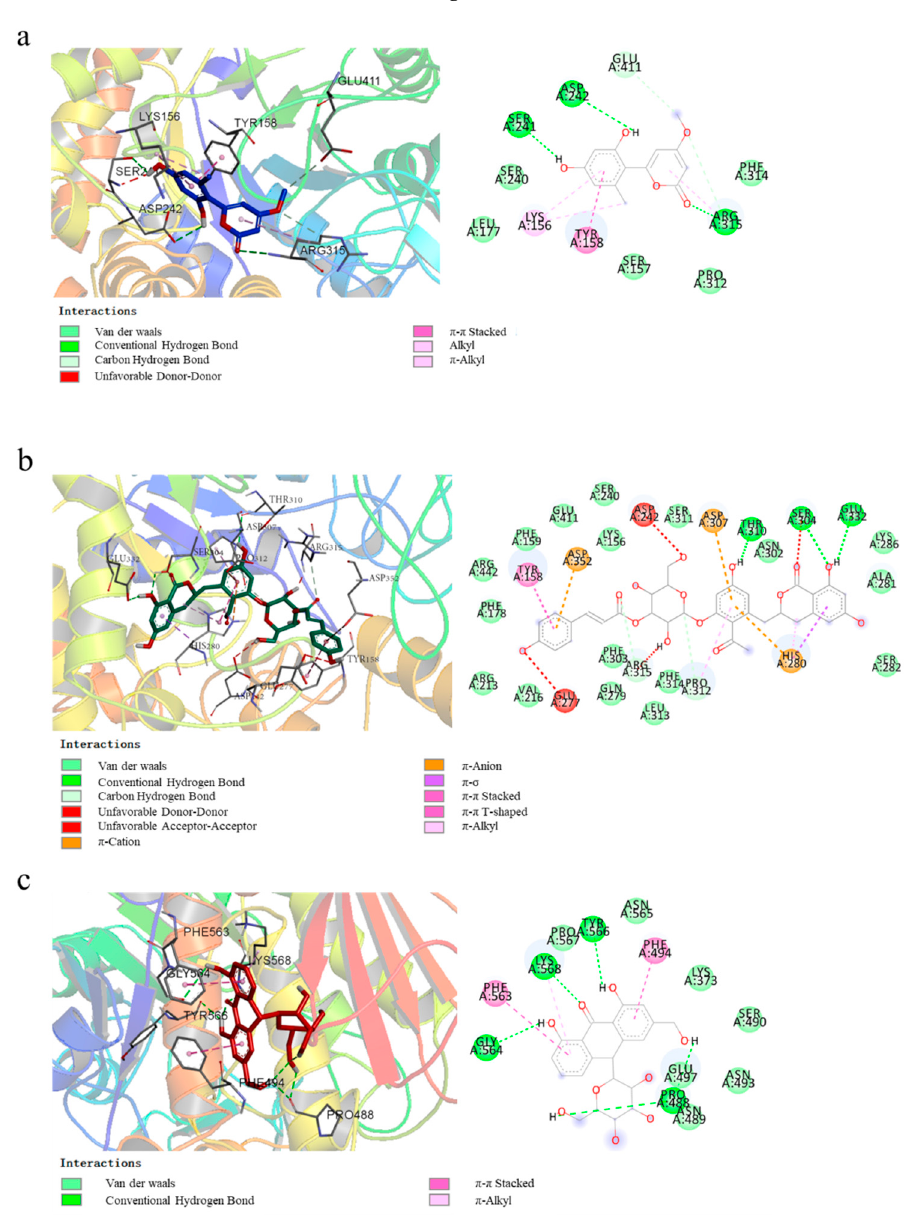
Figure 6. 2D and 3D molecular docking graphs of ( a ) compounds 1 , ( b ) compound 2 and ( c ) com- pound 3 with α -glucosidase.